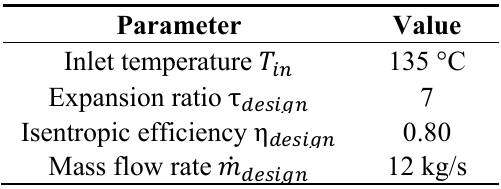
Table 2. Design conditions of the turbine.